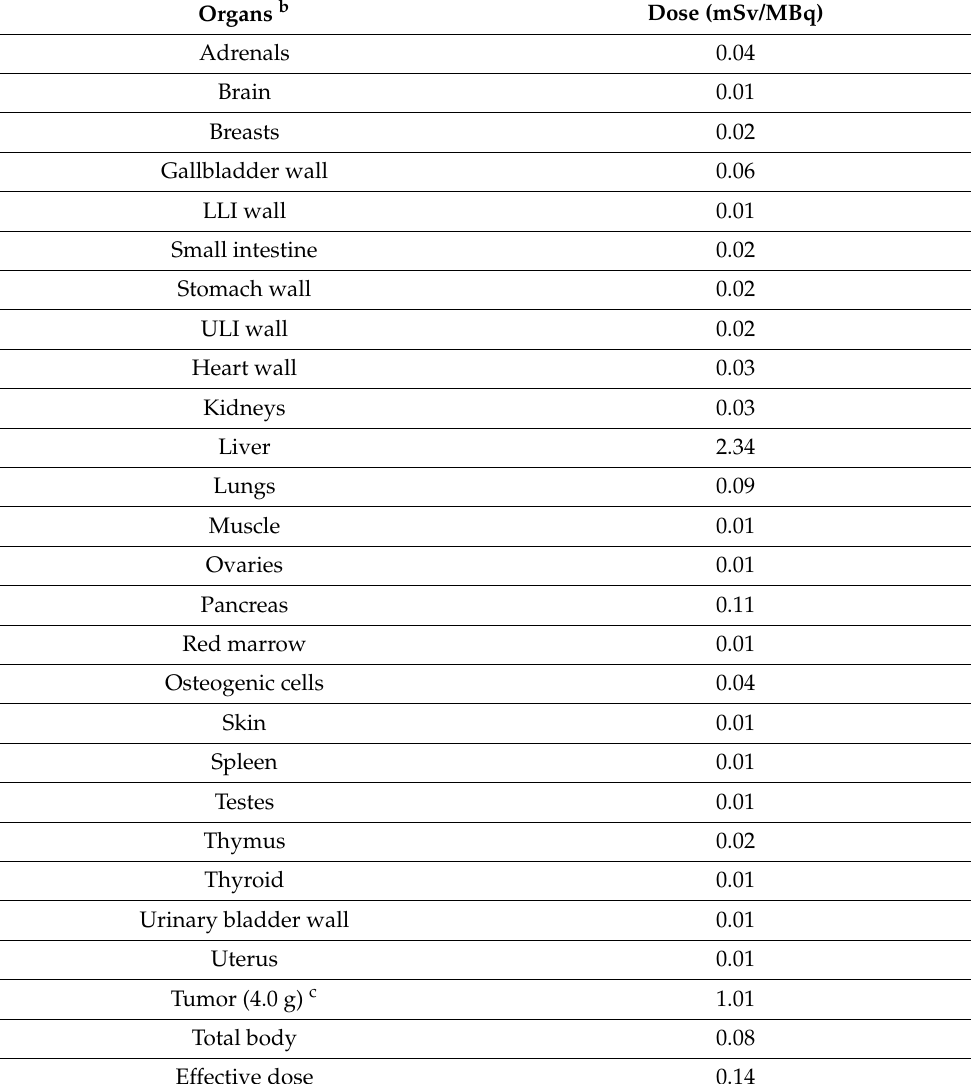
Table 2. Radiation dose estimates for intra-arterial injection of 177 Lu-DTPA-CMS in adult humans a . Organs b Dose